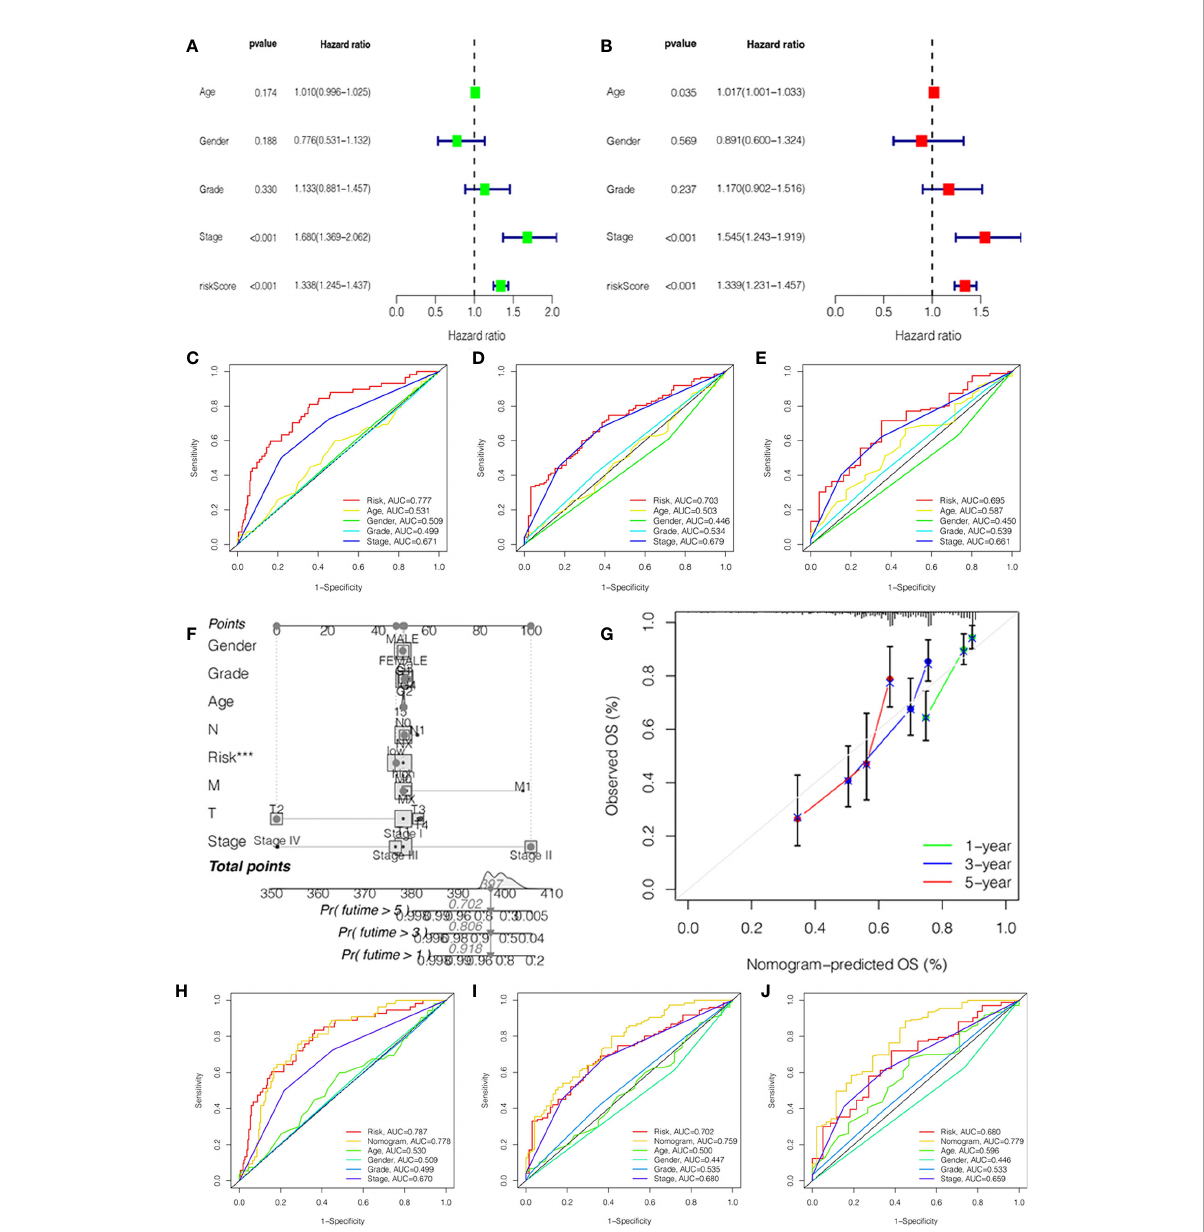
FIGURE 3 Independent prognostic value validation. (A) The relationship between the risk score and clinicopathological features by univariate Cox analysis. (B) The relationship between the risk score and clinicopathological features by multivariate Cox analysis. The AUC values of the ROC curve of 1 (C) , 3 (D) , and 5 years (E) for the risk score and clinicopathological features. (F) Nomogram for 1-, 3-, and 5-year OS prediction. (G) Calibration curves for 1-, 3-, and 5-year OS prediction. (H-J) The AUC values of the ROC curve of 1, 3, and 5 years for the